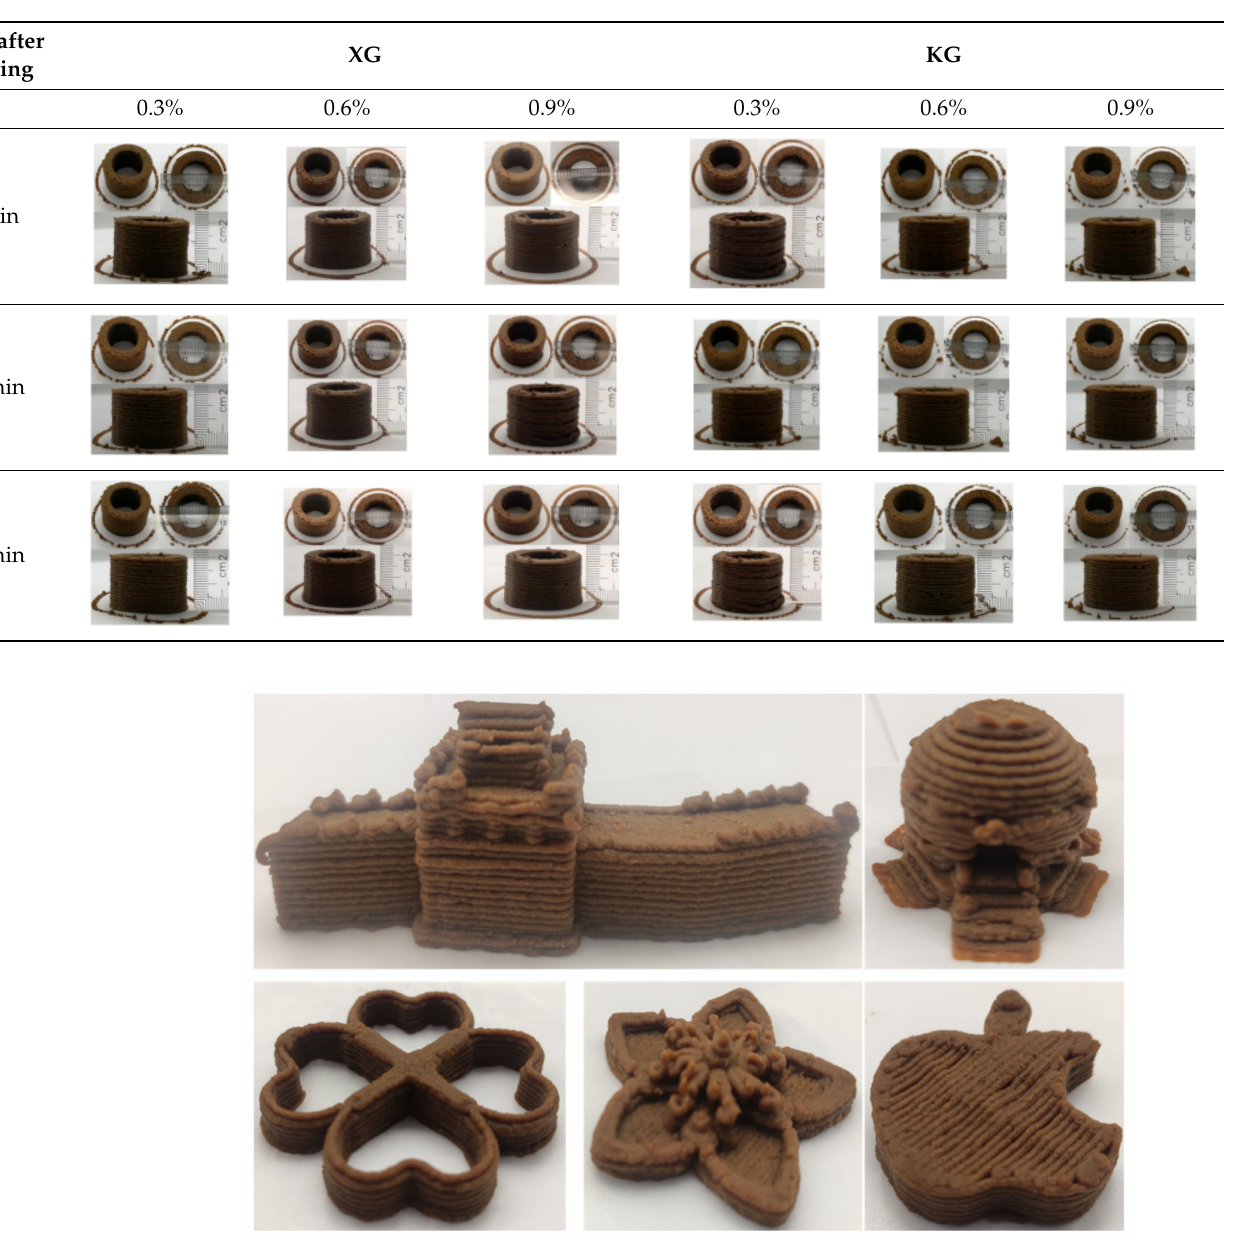
Figure 8. Pictures of 3D printed representative samples using XG-0.6% containing